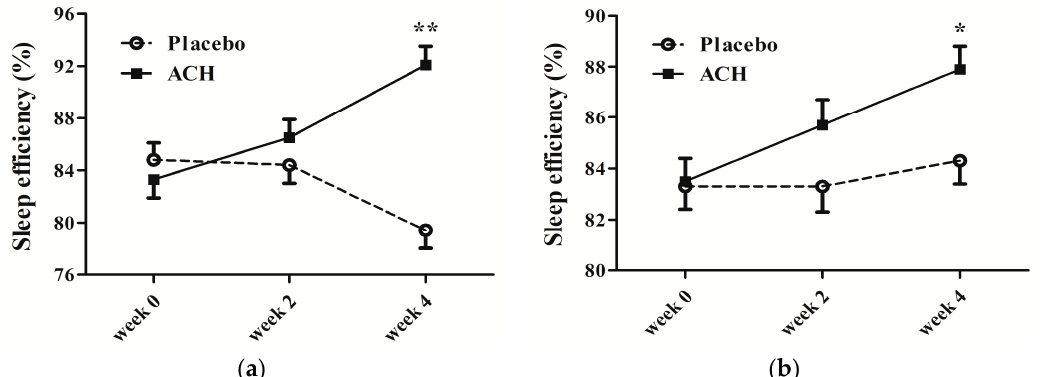
Figure 2. Comparison of effects of ACH administration duration on sleep efficiency. ( a ) Sleep diary showed constant improvement in sleep efficiency for ACH phase group compared with gradual deterioration for placebo group. Group difference in sleep efficiency over time became significant when ACH was administered for four weeks ( p < 0.001, q < 0.001 for 0–4 weeks), which did not reach statistical significance after two weeks of use ( p = 0.067 for 0–2 weeks). ( b ) Actigraphy revealed that sleep efficiency did not show clear differences between ACH and placebo phases; however, the significant improvement effect was only obvious after continuous use of ACH for four weeks ( p = 0.066 for 0–2 weeks vs. p = 0.007, q = 0.016 for 0–4 weeks). * q -value < 0.05 and ** q -value < 0.01, pFDR